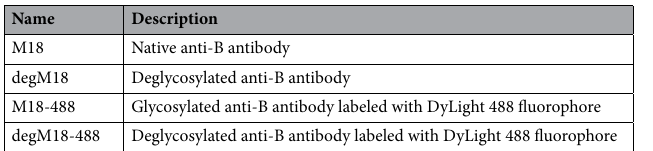
Table 1. IgG3 and its derivatives used in